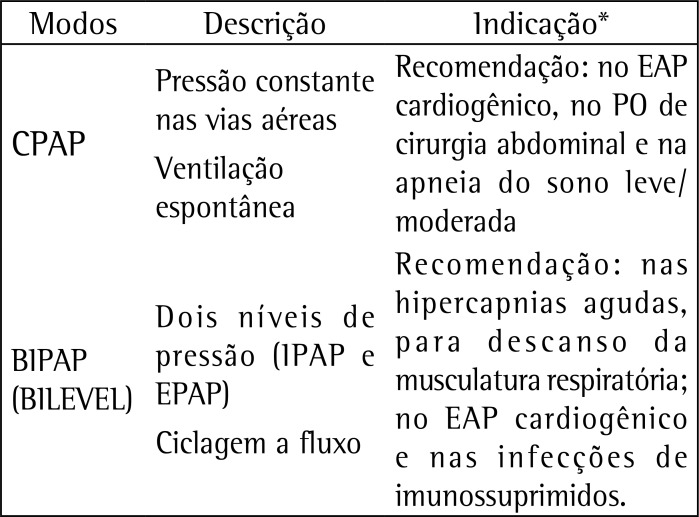
Tipos de modos ventilatórios para suporte não invasivo CPAP - pressão
positiva contínua nas vias aéreas; BIBAP - pressão positiva bifásica; EAP -
edema agudo de pulmão; PO - pos-operatório; IPAP - pressão inspiratória
positiva; EPAP - presssão expiratória positiva. *exceto se
contraindicado.